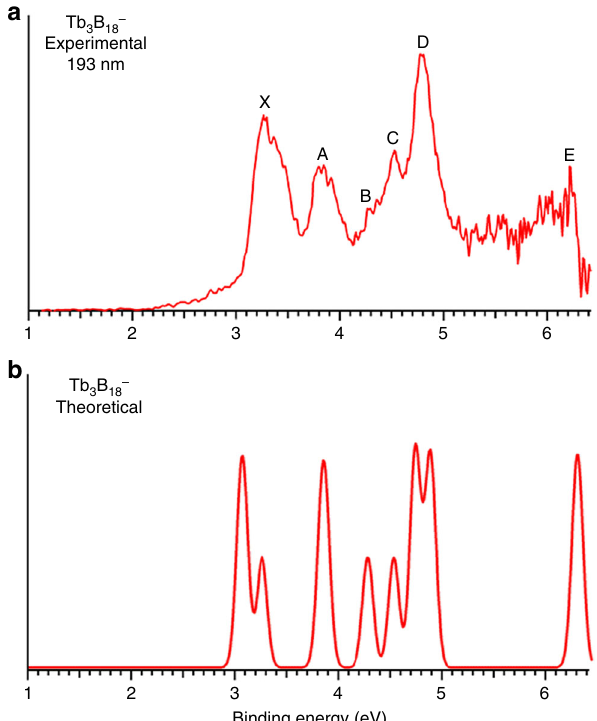
Fig. 2 Photoelectron spectrum of Tb 3 B 18 – . a At 193 nm. b The simulated spectrum.